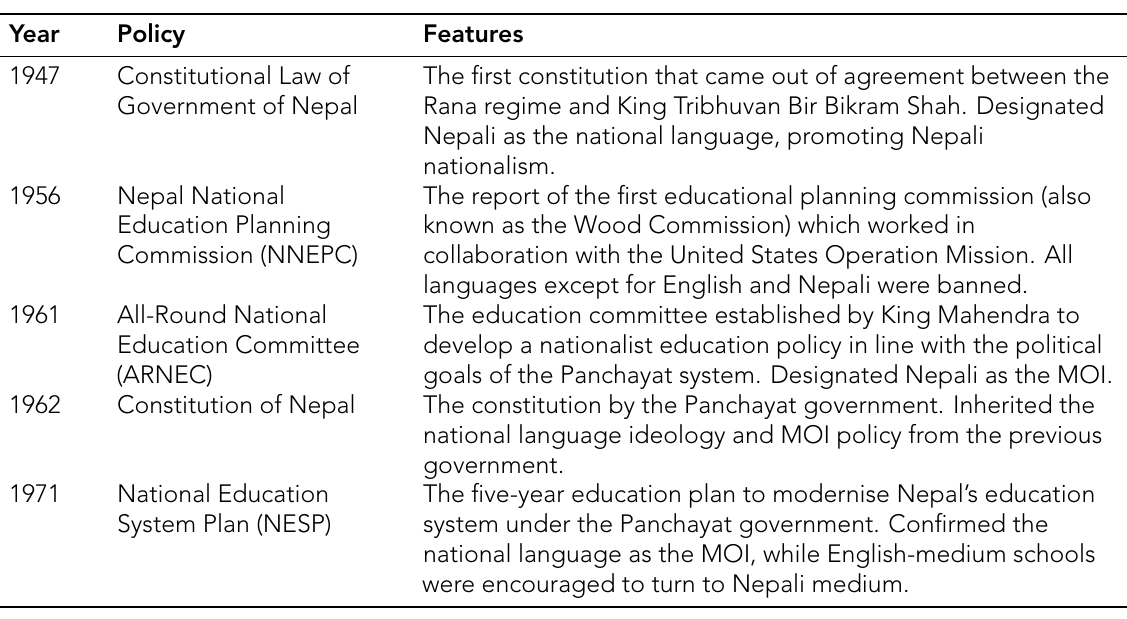
Table 1. Policy documents and their features (Source: Authors,